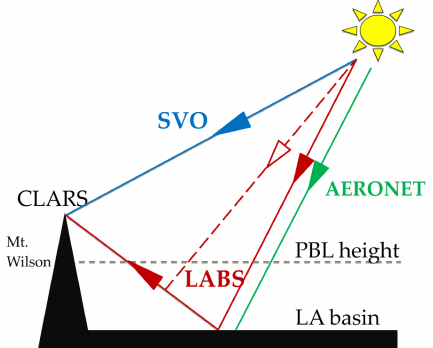
Figure 1. Schematic diagram of CLARS-FTS measurement ge- ometries for western Pasadena and the AERONET site at Caltech. CLARS-FTS has two modes of operation, including Los Angeles Basin Survey mode (LABS; in solid red) and the Spectralon View- ing Observation mode (SVO; in blue). An example of light path change due to aerosol scattering along the path from the basin to the mountain top is illustrated (in dotted red). Also shown is the light path of AERONET-Caltech (in